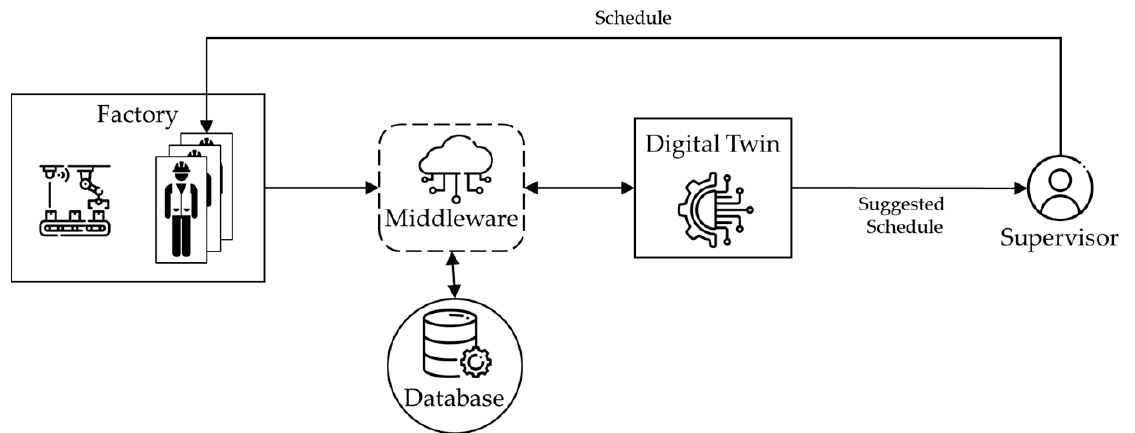
Figure 1. Shopfloor—human scheduling DT relations diagram.